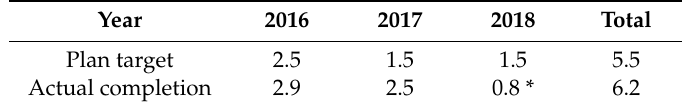
Table 2. Completion of China’s coal de-capacity target (hundred million